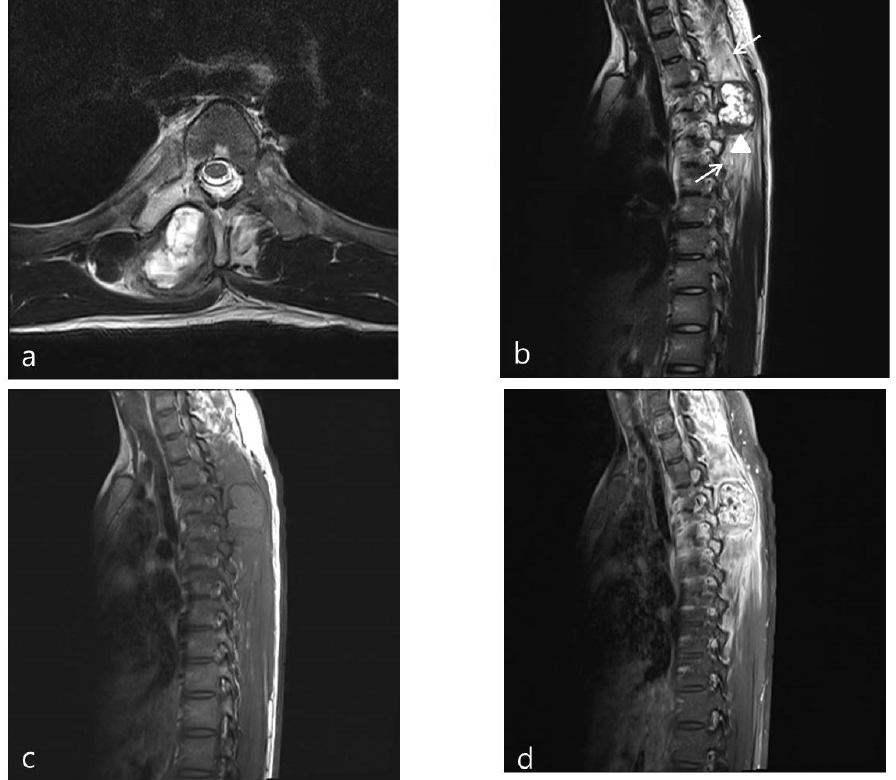
Figure 3. Axial ( a ) and sagittal ( b ) T2-weighted MR images show heterogeneous high SI mass in the right paraspinal area between the spinous and right transverse process of T4,5. The calcified rim (arrowhead) is shown as low SI on T2- and T1-weighted images and extensive peritumoral edema (arrows) was also noted. The mass show iso-SI on the T1-weighted image ( c ). On an enhanced ( d ) axial image, the mass shows heterogeneous enhancement.